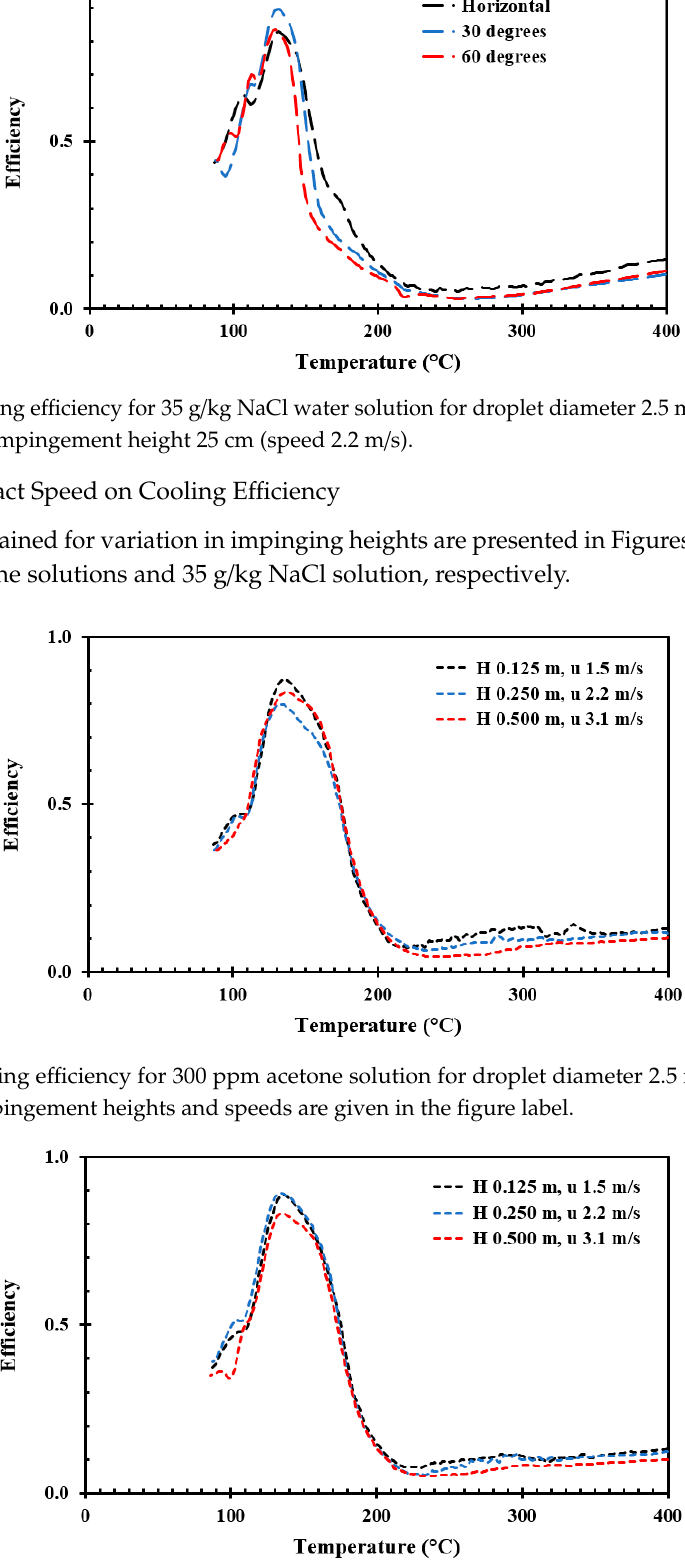
Figure 16. Cooling efficiency for 700 ppm acetone water solution for droplet diameter 2.5 mm, and various orientations at impingement height 25 cm (speed 2.2 m/s).